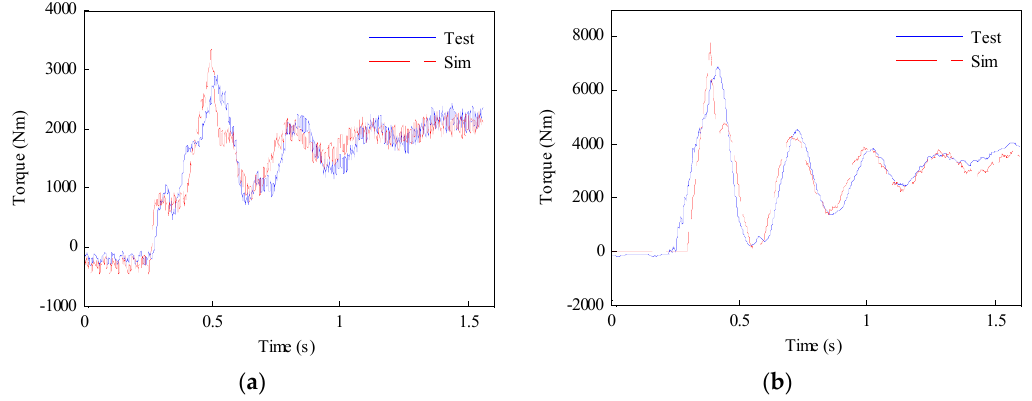
Figure 9. Comparison of simulation and test data in shifting process. ( a ) Torque on the engine output shaft; ( b ) torque on the transmission output shaft.